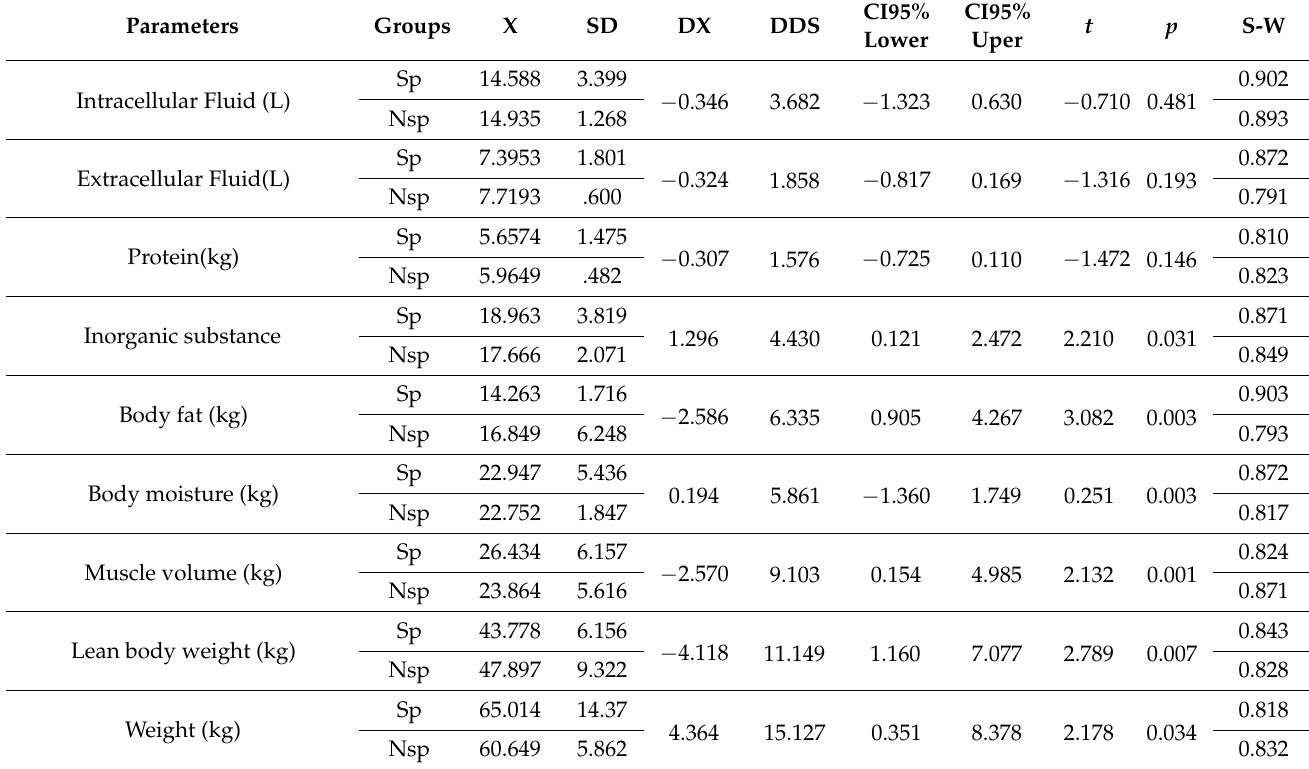
Table 7. Statistical analysis of nourishment for the female